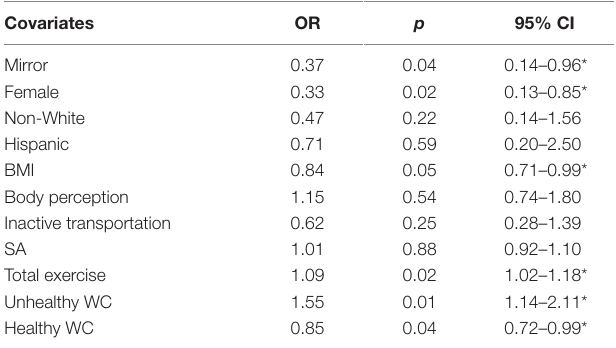
TaBle 2 | Odds ratios (Or) for stair use